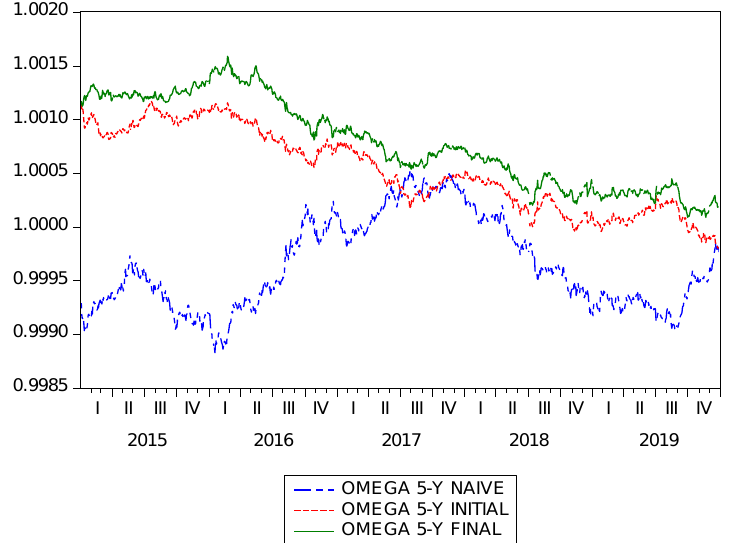
Figure 6. Omega ratios of strategies (5-year rolling window). This figure displays the 5-year rolling window Omega ratios over the out-of-sample period for the naïve strategy, the best strategy using logarithm returns, labeled as initial, and the best one using standardized returns, labeled as final. Table 9. Data snooping